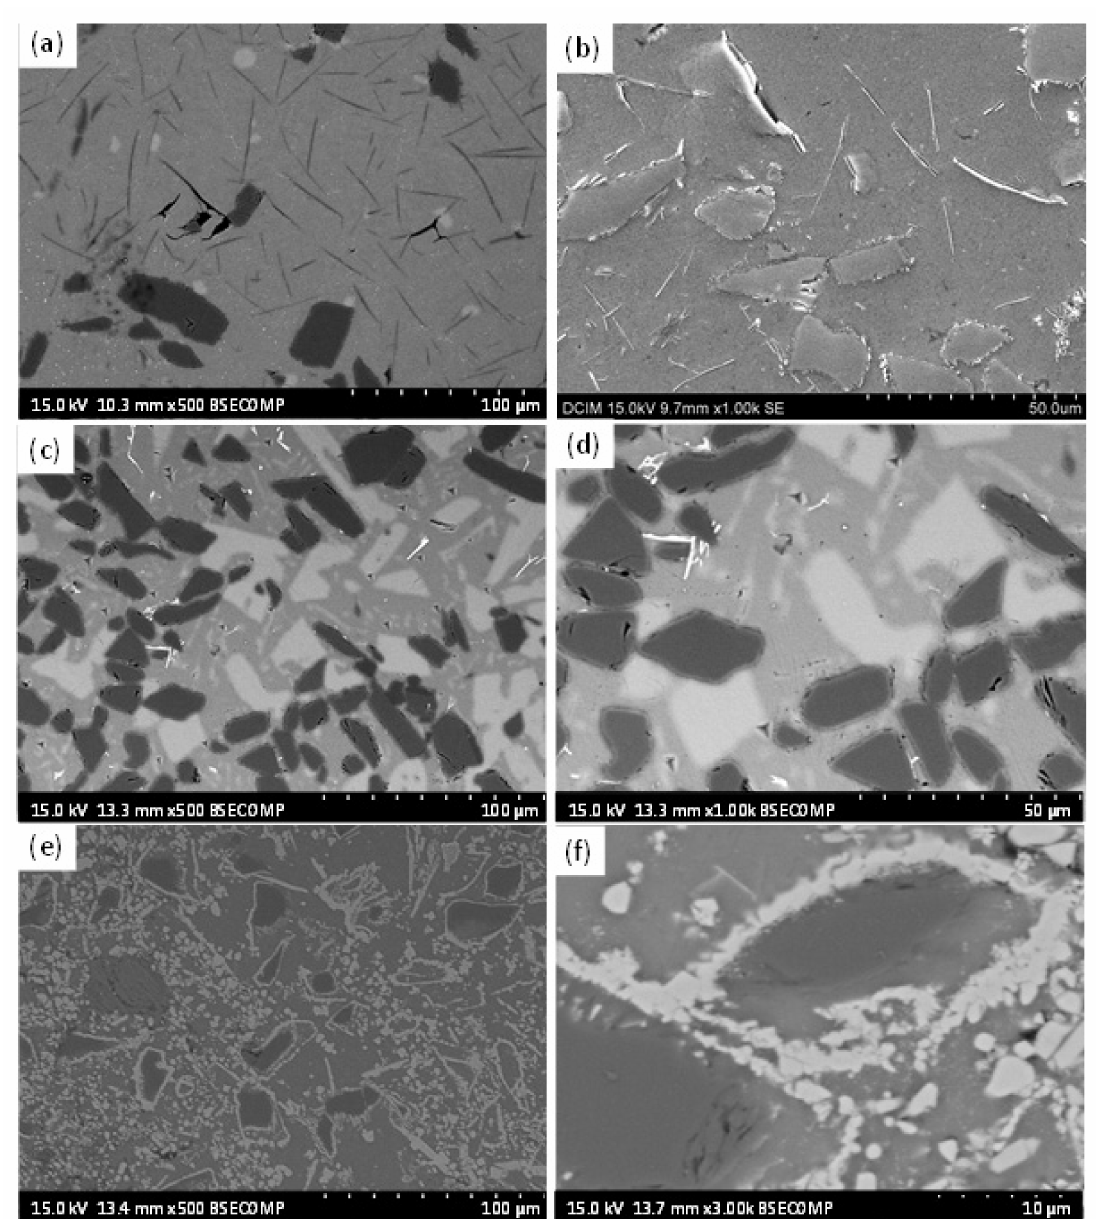
Figure 2. Microstructure of ( a ) Al12Si/SiC coating; ( b ) detail of ( a ); ( c ) Al40Si/SiC coating; ( d ) detail of ( c ); ( e ) Al12Si-Ti/SiC coating; and ( f ) detail of ( e